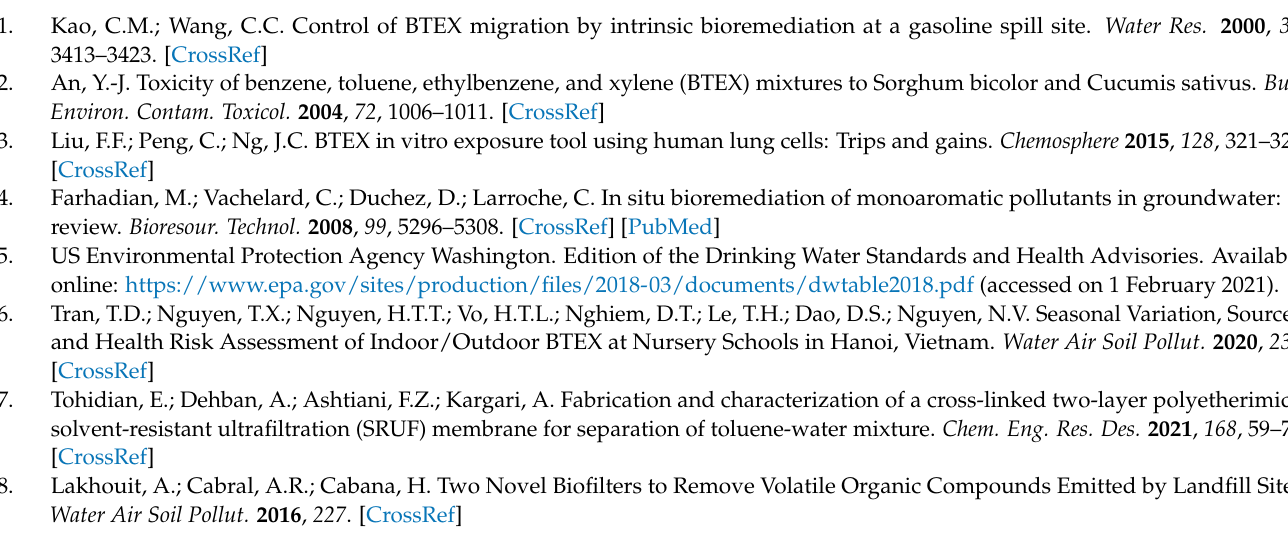
Figure S3: Modeling procedure for the Langmuir sorption isotherm (Langmuir constant ( K l ); total concentration of sorption sites available ( b )): (a) K l = 1.0 ~ 1.0 × 10 4 ; b = 1.0 × 10 − 5 ~ 1.0; (b) SSR = 1.2 × 10 4 ~ 1.25 × 10 4 , (c) K l = 2.35 × 10 3 ~ 2.25 × 10 3 ; b = 5.7 × 10 − 4 ~ 5.9 × 10 − 4